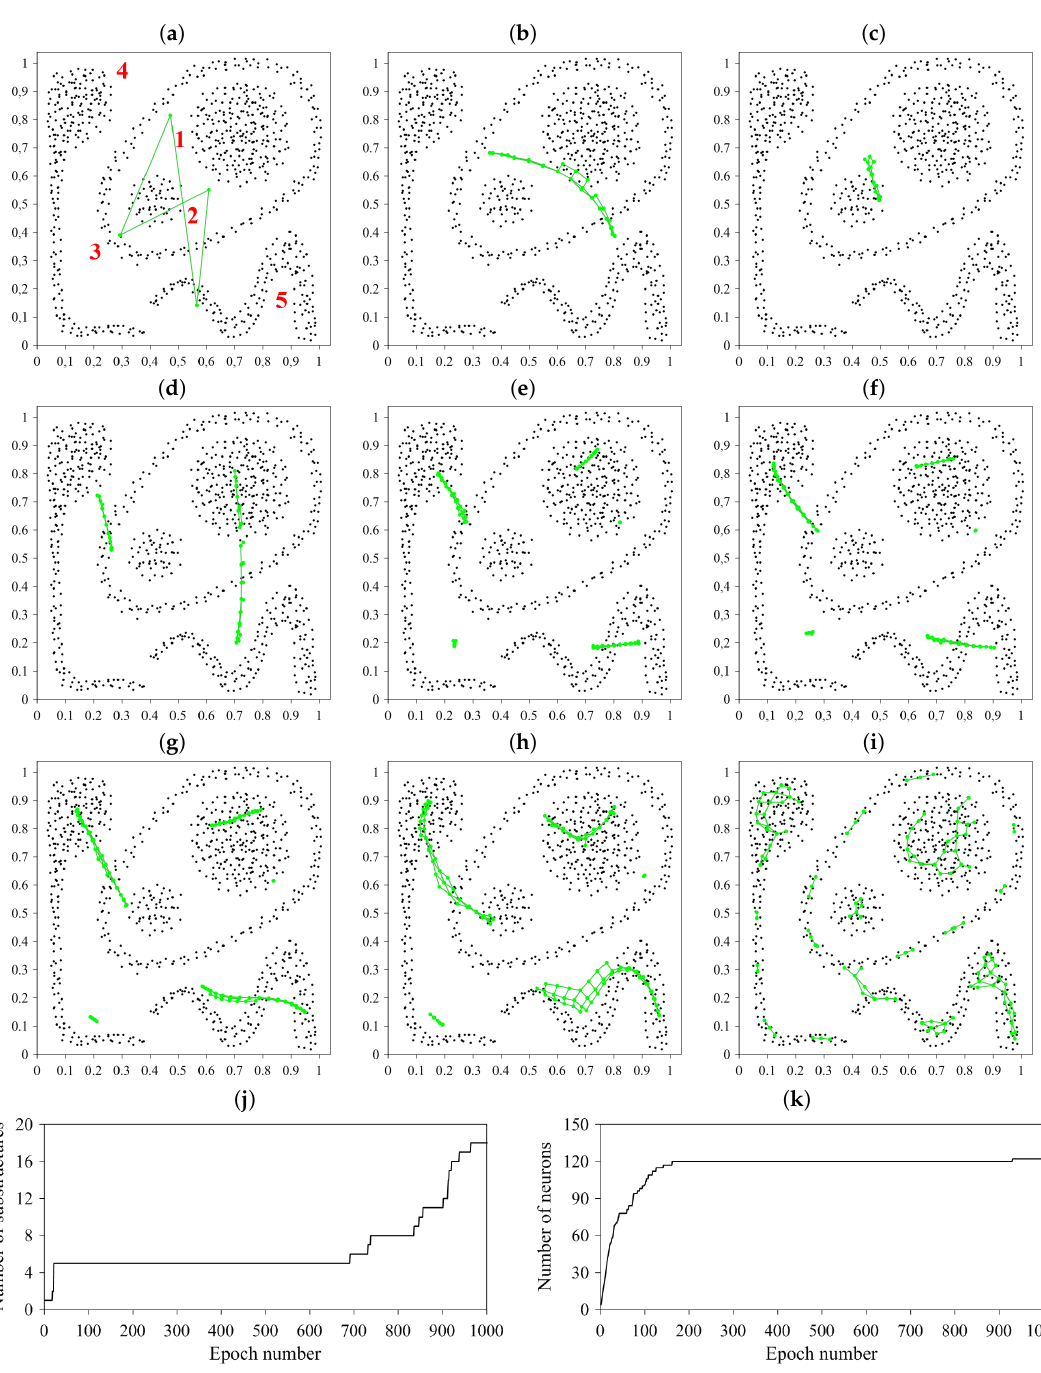
Figure 13. The evolution of IGG in the synthetic data set of Figure 6a in learning epochs: ( a ) No. 0 (start of learning), ( b ) No. 5, ( c ) No. 10, ( d ) No. 20, ( e ) No. 30, ( f ) No. 50, ( g ) No. 100, ( h ) No. 500, and ( i ) No. 1000 (end of learning) as well as plots of the number of substructures ( j ) and the number of neurons ( k ) vs. epoch